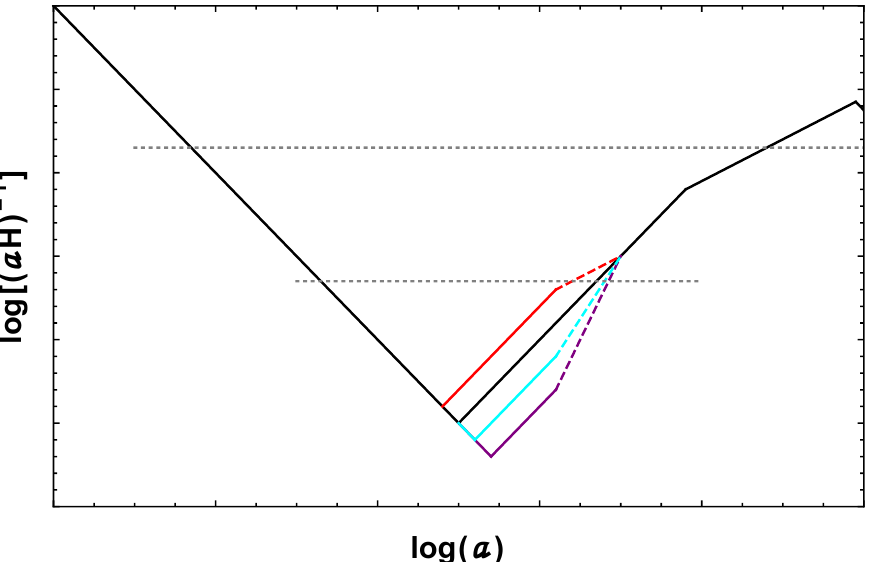
Figure 2. Evolution of the horizon scale ( aH ) − 1 with the scale factor (both plotted in log). The standard Λ CDM+Inflation evolution is shown with the solid black line. Red, cyan and purple plots signify alternate evolutions in the presence of a non-standard post-inflationary epoch with w = 0, 2/3 and 1, respectively. Evolutions in the non-standard epochs are shown with dashed lines, whereas standard but shifted evolutions before that are shown with colored solid lines. Dotted grey lines represent cosmological